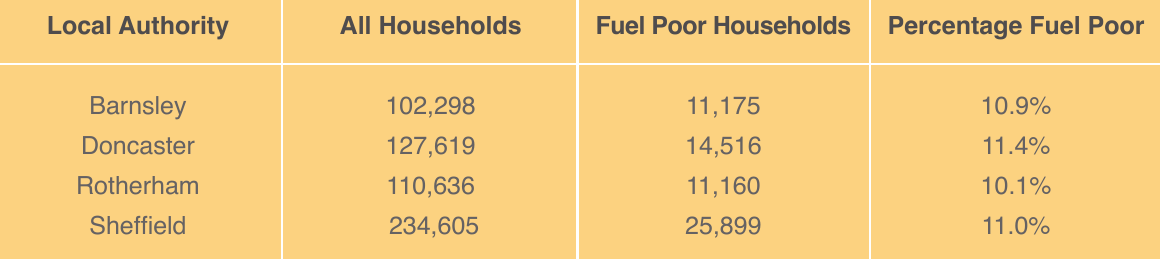
Table 1. Fuel poverty in South